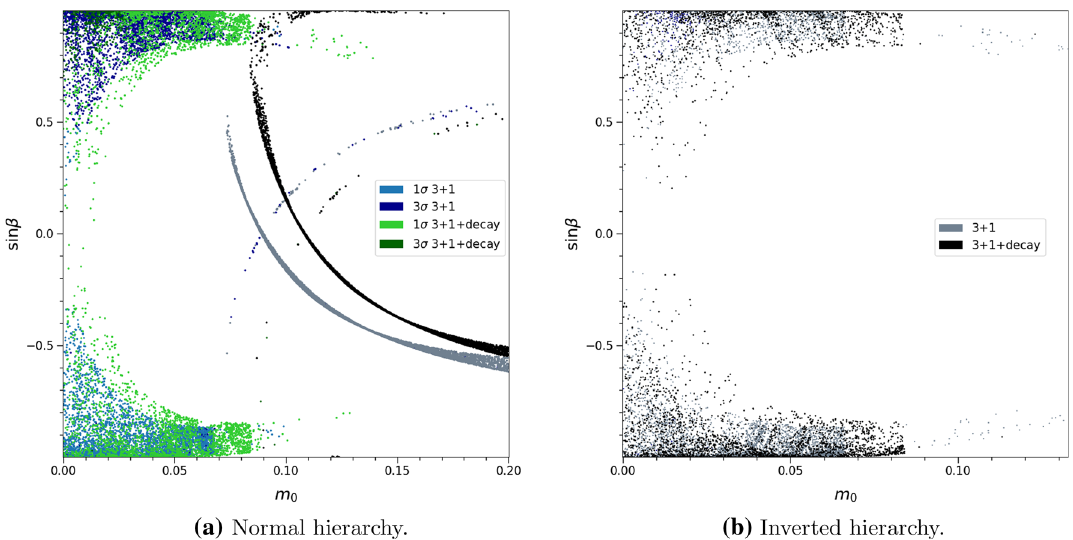
Fig. 4 sin β as a function of the lightest neutrino mass m 0 . The majority of the positive values for NH correspond to the 3 σ interval for δ CP while the negative ones are within 1 σ